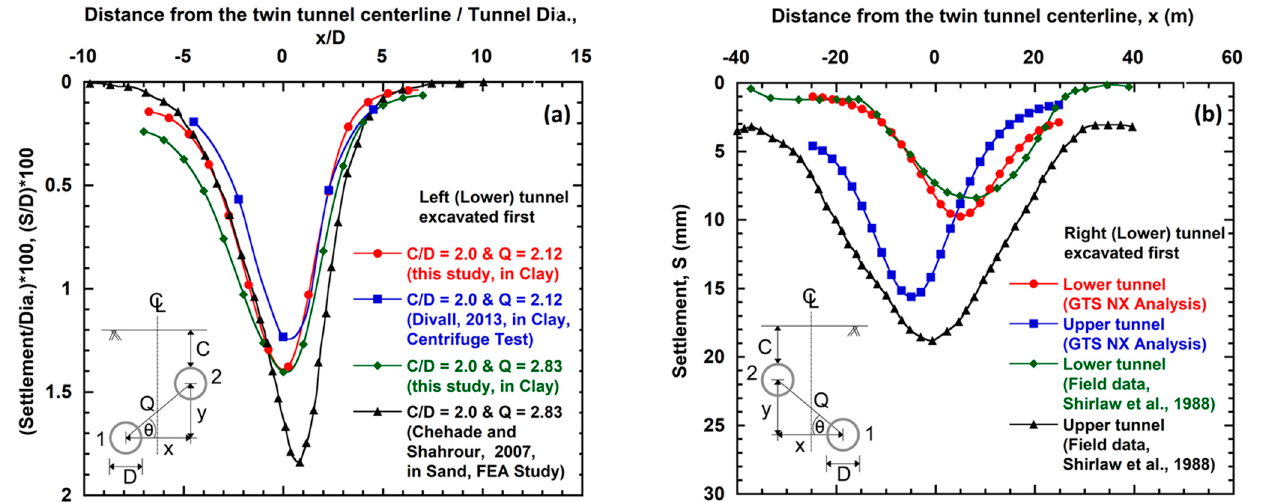
Figure 7. Model validation: ( a ) comparison between normalized total settlement of offset arrangement twin tunnels observed in this study and in similar published studies, ( b ) comparison of field observed settlement data with FEM analyses for two offset arrangement twin tunnels.